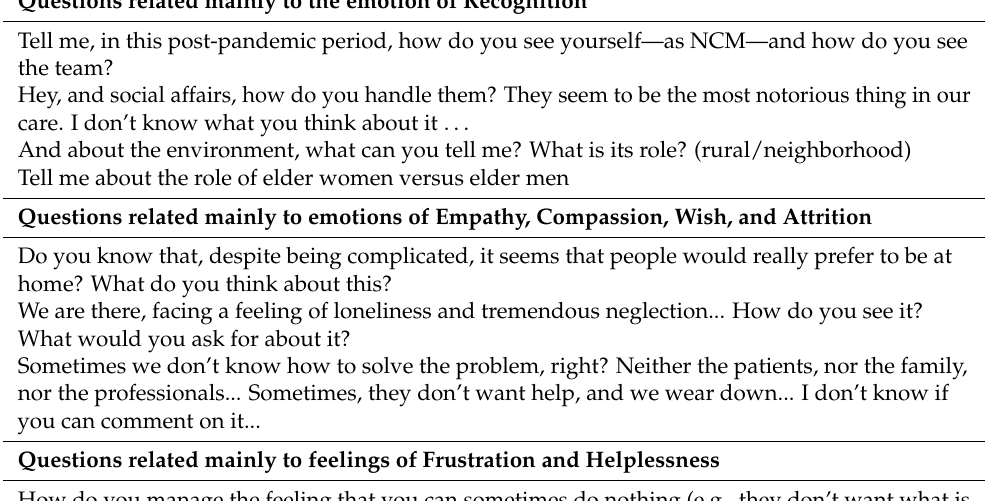
Table 1. Script of the semi-structured interview and focus group interview. NCM: nurse case managers. Questions related mainly to the emotion of